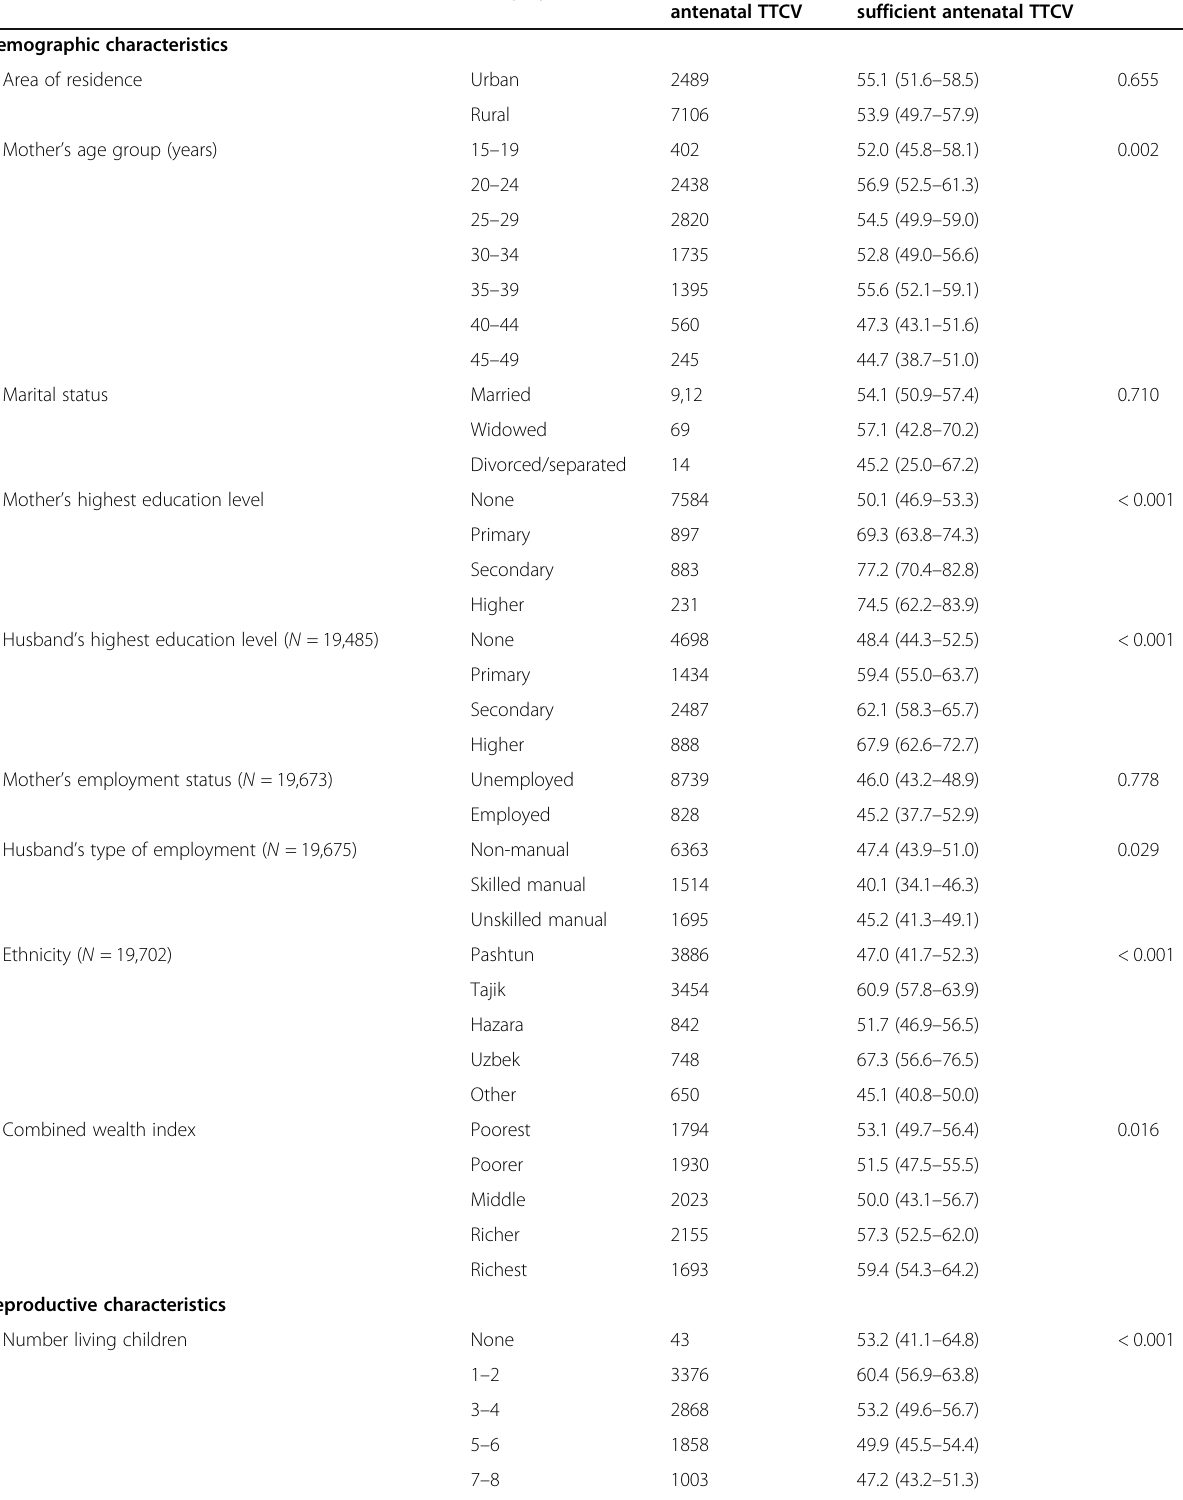
Table 2 Associations between various independent variables and a woman having sufficient TTCV in her most recent pregnancy resulting in a live birth within the past 5 years a